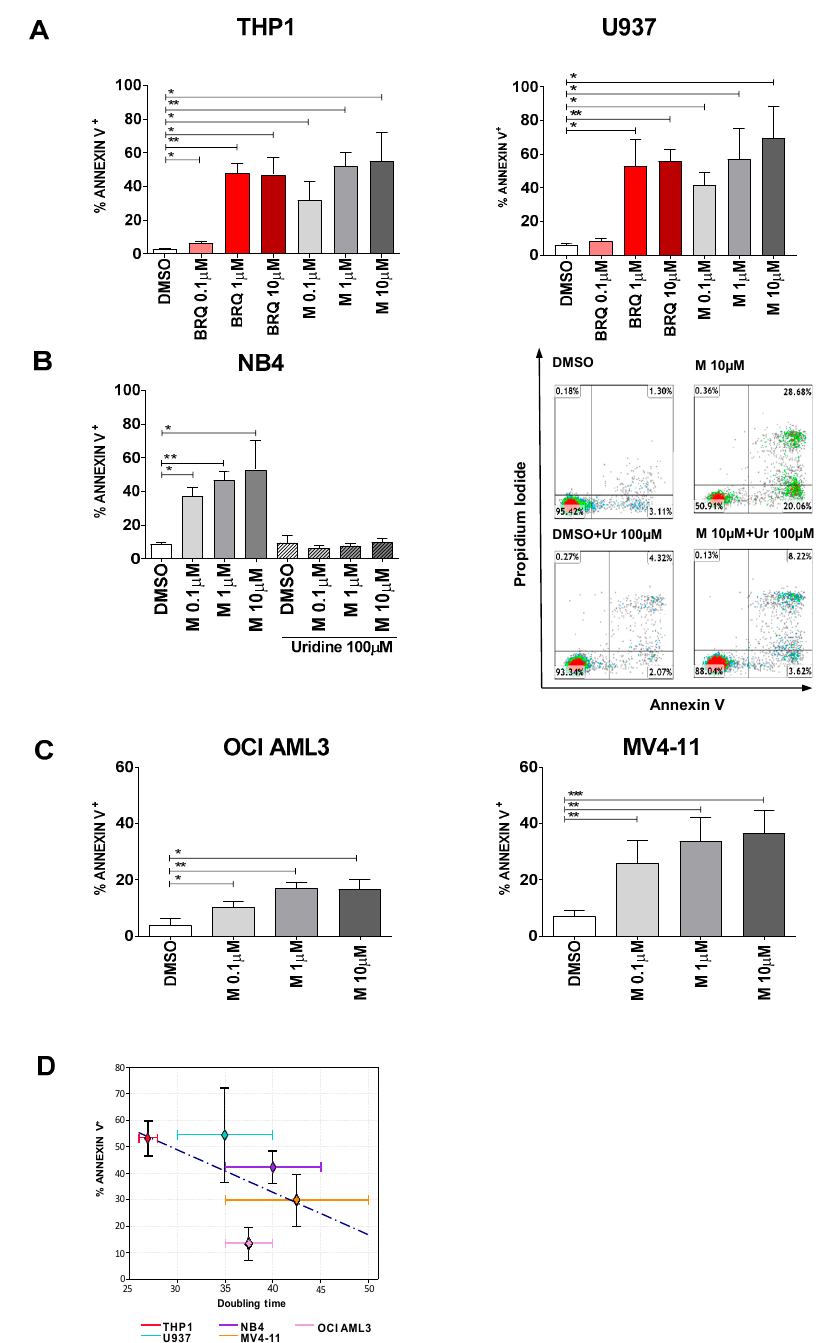
Figure 1. MEDS433 induces apoptosis in several acute myeloid leukemia (AML) cell lines (I). ( A ) Comparison between the apoptotic rate induced by MEDS433 and brequinar at different concentrations ( n = 3). ( B ) Hyperphysiological levels of uridine (100 µ M) abrogate the apoptotic effect of MEDS433 ( n = 3). Right panel: Flow cytometry plots of a representative experiment of NB4 cells treated with MEDS433 ± uridine. ( C ) OCI AML3 ( n = 4) and MV4-11 ( n = 5) have a reduced sensitivity to MEDS433 compared to THP1, U937 and NB4 cell lines. ( D ) Regression line correlating the apoptotic rate induced by MEDS433 and the doubling time of tested AML cell lines. Apoptosis was evaluated after 3 days of treatment through Annexin V expression. DMSO indicates cells treated with dimethyl sulfoxide only. M: MEDS433. BRQ: brequinar. Ur: uridine. Statistical significance: t -test, * p < 0.05; ** p < 0.01; *** p <